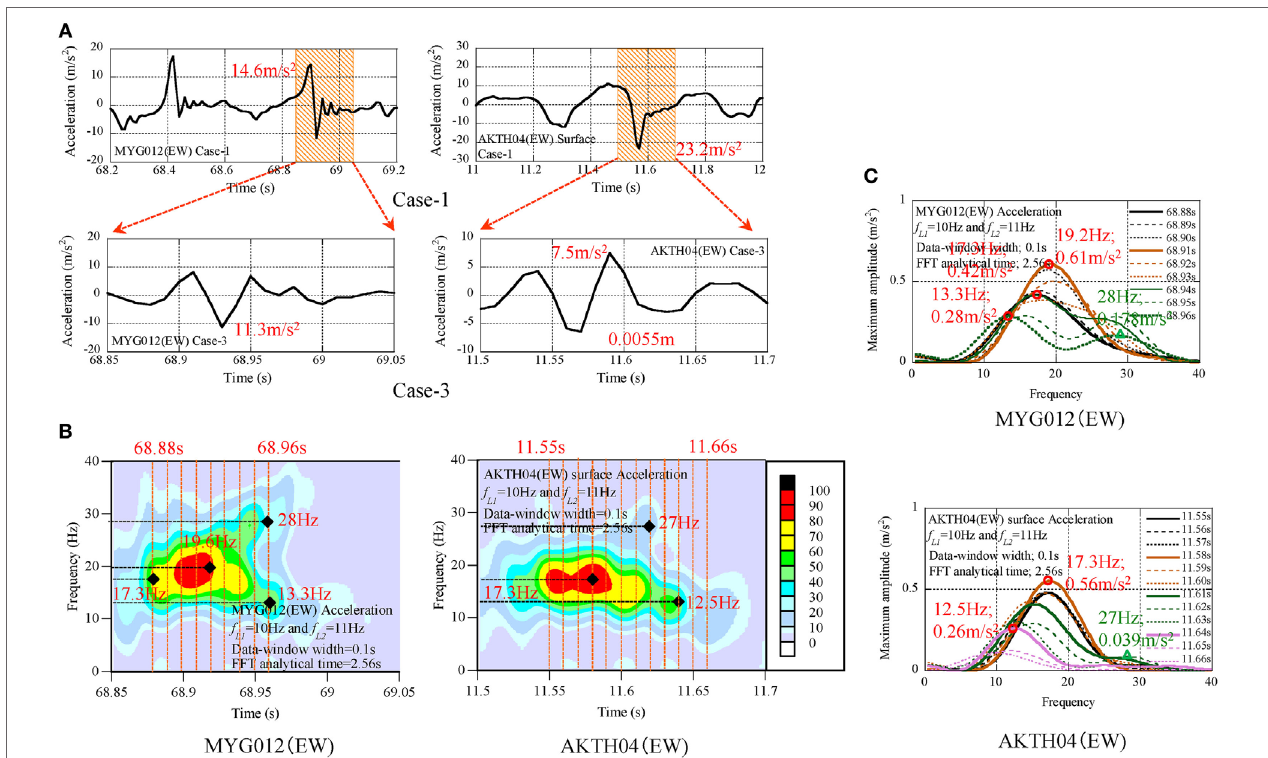
FigUre 10 | Comparison of pulse wave in MYG012 (EW) and AKTH04 (EW): surface, (a) acceleration and displacement profiles, (b) non-stationary Fourier spectra, (c) transient process of amplitude